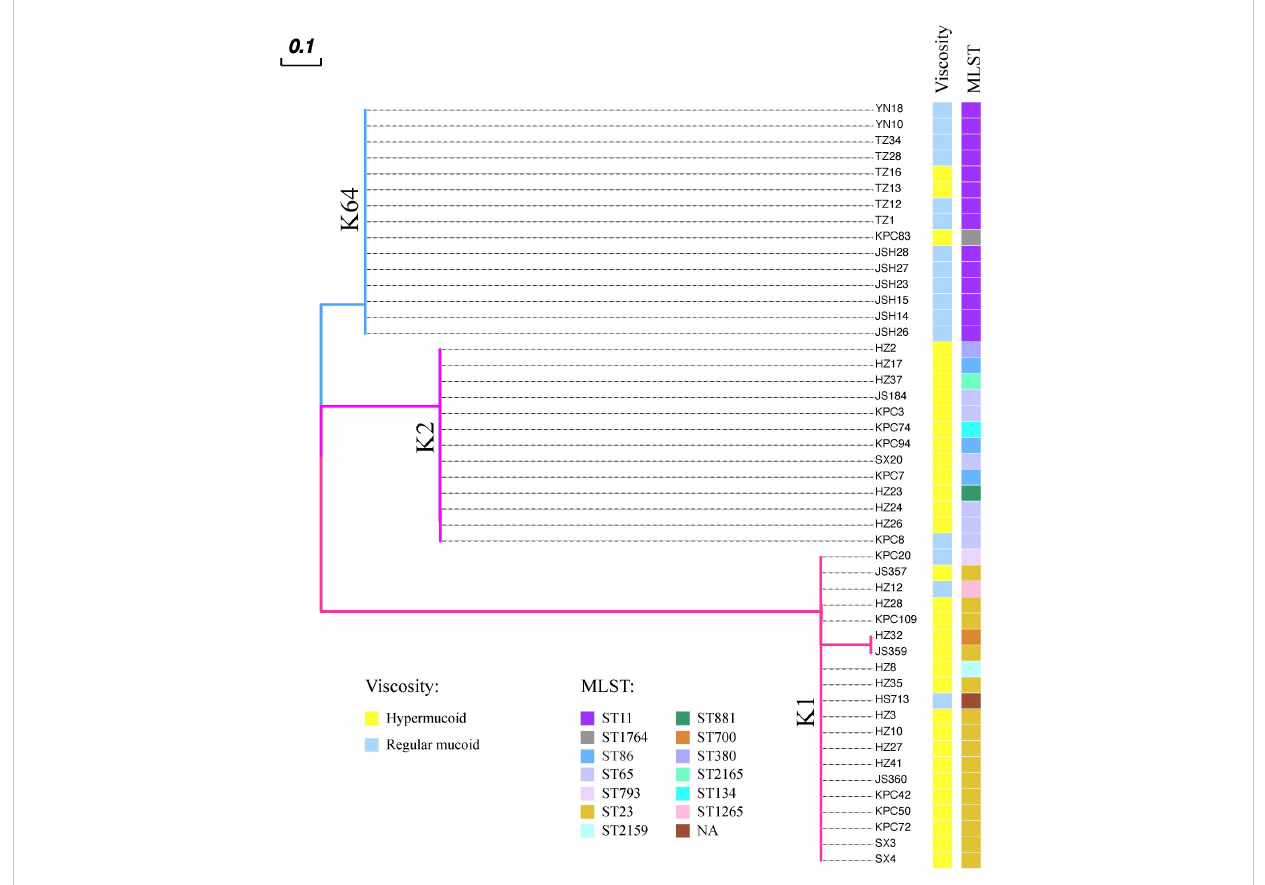
FIGURE 2 The distribution of wcaJ among distinct Klebsiella pneumoniae serotypes (K1, K2, and K64) in 48 clinical hvKp isolates. Each color branch represents a different serotype. The wcaJ sequences within the same serotype are identical. The MLSTs are displayed for different strains; presence of hypermucoid (> 5 mm) or normal capsules was determined using string